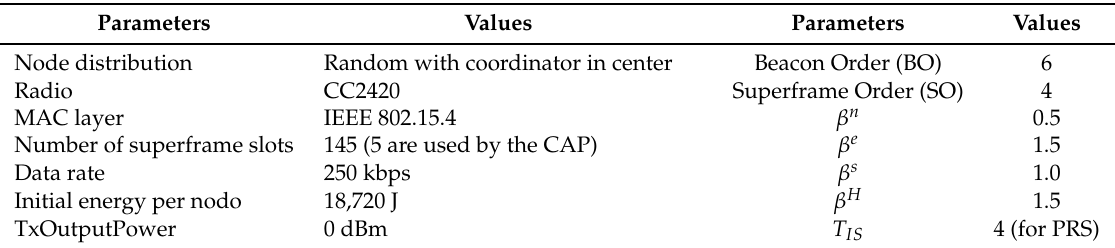
Table 2. Simulation